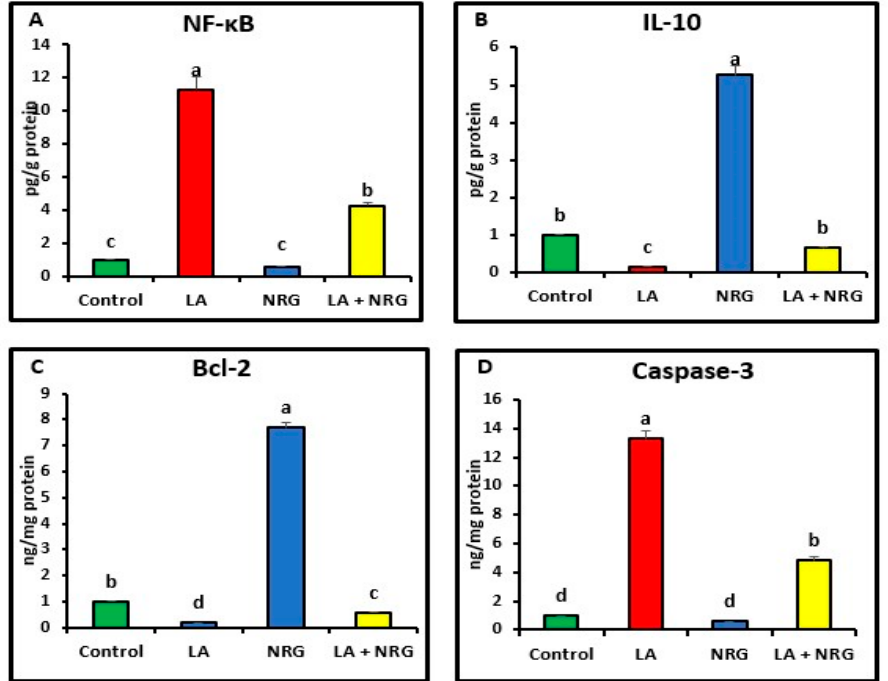
Figure 7. Brain pro- and anti-inflammatory mediators: ( A ) NF- κ B (Pg/g protein), ( B ) IL-10 (Pg/g protein), ( C ) BCL-2, and ( D ) caspase-3 in the di ff erent experimental groups at the 4 th week of treat- ment of LA-intoxicated rats with NRG (mean ± SE). The means in each chart with di ff erent super- scripts are signi fi cantly di ff erent ( p < 0.05). NF- κβ : nuclear factor kappa-B; IL-10: interleukin 10; BCL-2: B-cell lymphoma 2; caspase-3: cysteine-aspartic proteases. a for the high value; b, c for inter- mediate values between a and d, while d for the lower value . 3.5. Protective E ff ect of Naringenin (NRG) on Histopathological Alterations in Hepatic and Brain Tissues of Lead-Intoxicated Rats 3.5.1. Hepatic Tissue The hepatic histological changes and lesion scores in the tested groups are shown in Figure 8A–D. In the LA-intoxicated group, there was signi fi cant mononuclear cell in fi ltra- tion in the portal area, but the LA + NRG group showed mild mononuclear cell in fi ltration in this area.